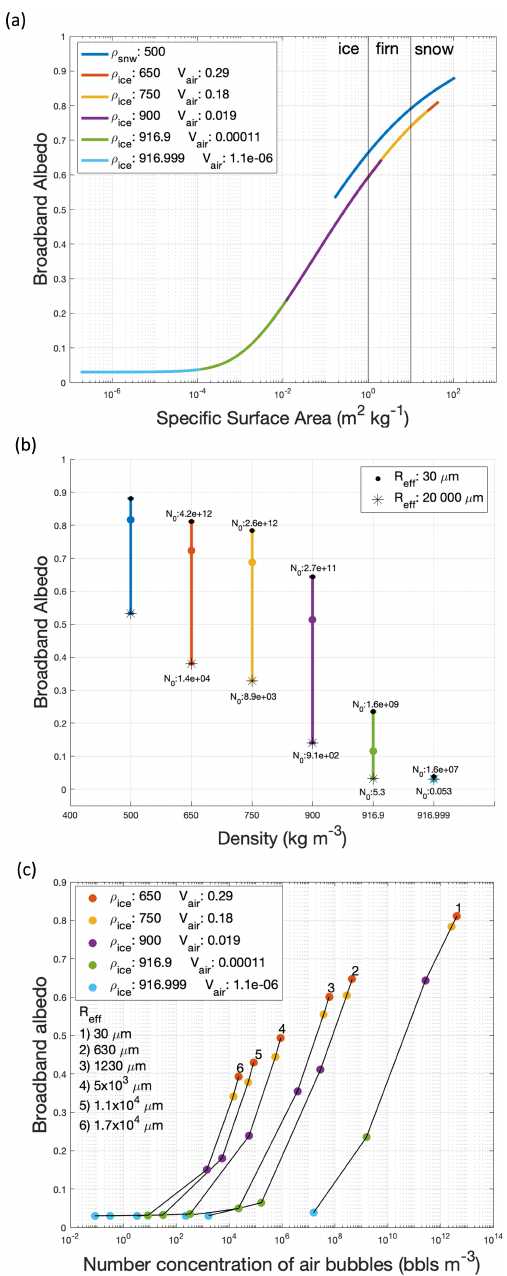
Figure 4. (a) Broadband albedo as a function of specific surface area, density, and volume fraction of air. The blue 500 density line is represented as snow; all other constant density lines are represented as ice. Model configuration is the same as Fig. 3. (b) Broadband albedo as a function of snow and ice density. Number concentration labels indicate the number concentration of air bubbles within the ice. Black stars indicate a bubble radius of 20000µm, black dots indicate a bubble radius of 30µm, and colored dots indicate a bubble radius of 180µm. (c) Broadband albedo as a function of number concentration of air bubbles. The lines indicate constant air bubble radius. The colored dots show where each corresponding ice density is reached for the combination of radius and number concentration.